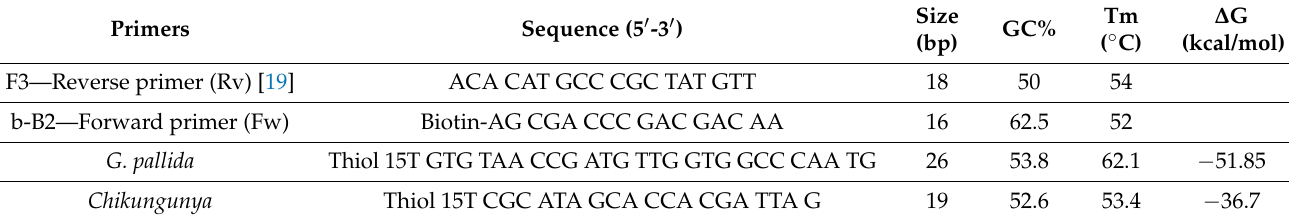
Table 2. Sequence, size, GC content, and melting temperature (Tm) of a universal pair of primers designed based on the ITS-rDNA of Globodera pallida and the change in free energy of hybridization ( ∆ G) of the oligonucleotide probe specifically designed to target Globodera pallida, and of the negative control